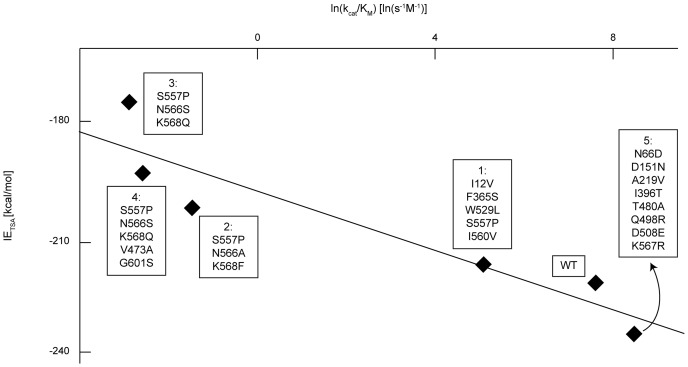
Computationally-determined IETSA for pNP-GLU versus experimental ln(kcat/KM).Data was collected as described in Figure 5. Enzyme variants with higher catalytic efficiency (kcat/KM) have a stronger affinity for 1,5-glucarolactone (R2 = 0.864). See also Figure S3.